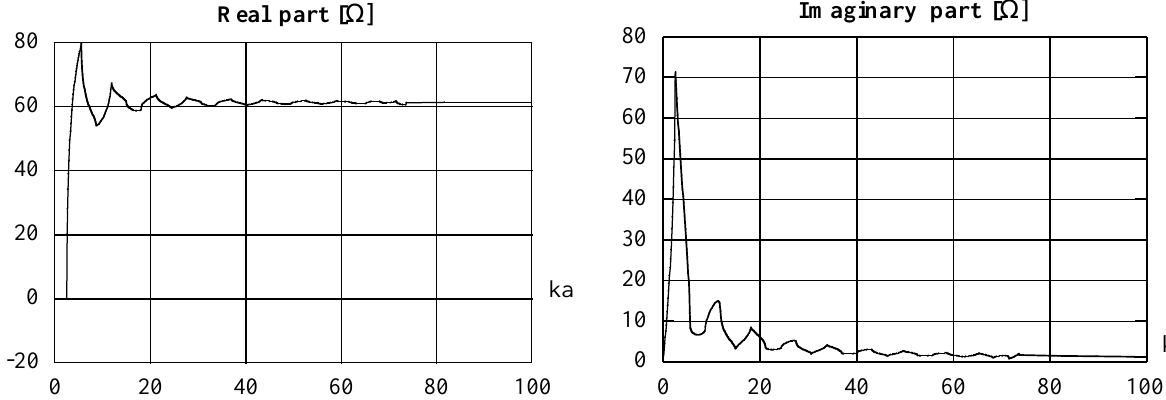
FIG. 19. Real and imaginary parts of the longitudinal coupling impedance in the case (cid:119) (cid:173) (cid:51) (cid:121) (cid:53) and b (cid:173) (cid:49) .